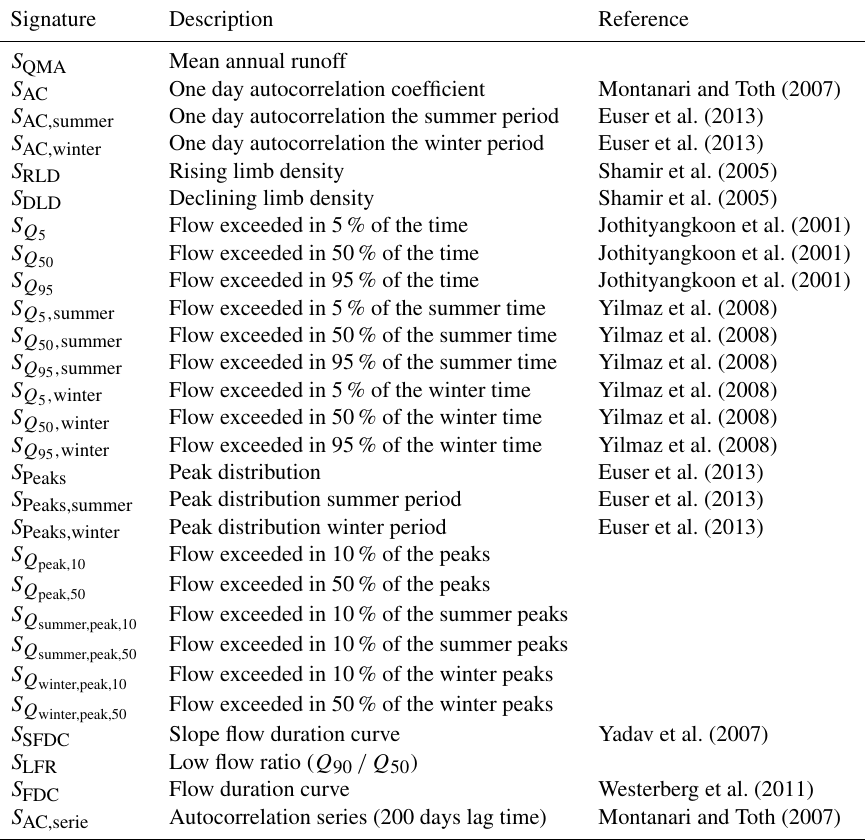
Table 3. Overview of the hydrological